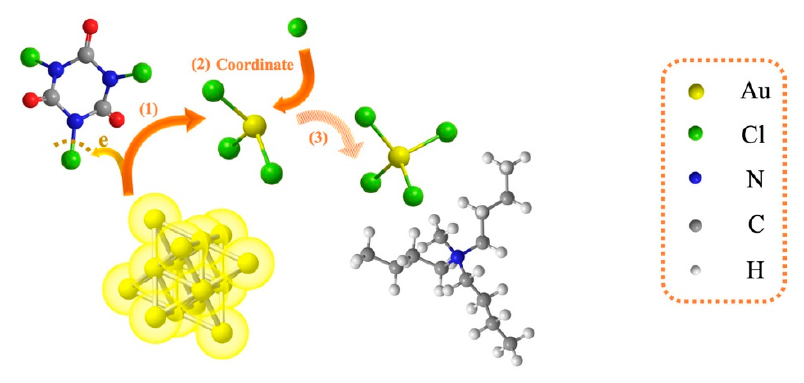
Figure 5. Reaction mechanism diagram.